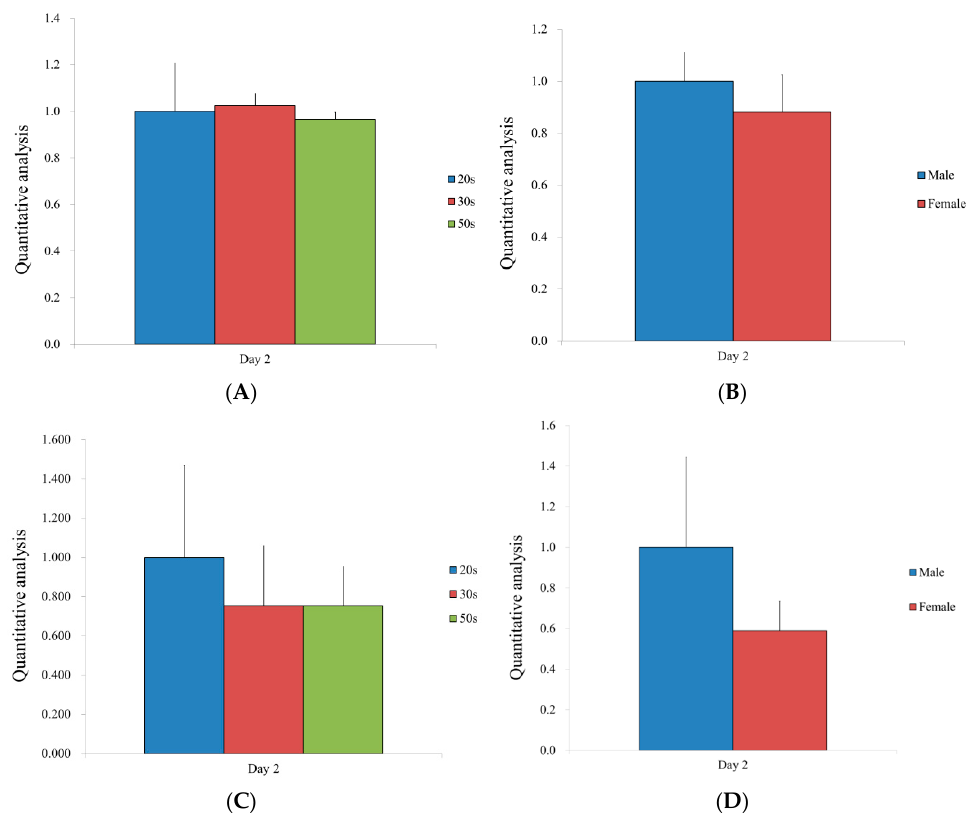
Figure 3. ( A ) Runx2 gene expression of hBMSCs according to age. ( B ) Runx2 gene expression of hBMSCs according to sex. ( C ) Collagen I gene expression of hBMSCs by age. ( D ) Collagen I gene expression of hBMSCs by sex.